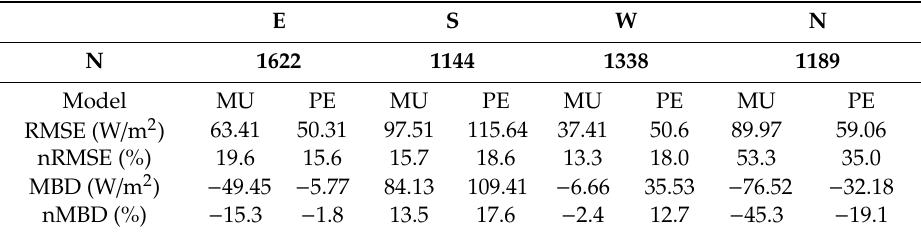
Table 4. Results after filtering data by Sun elevation angles.